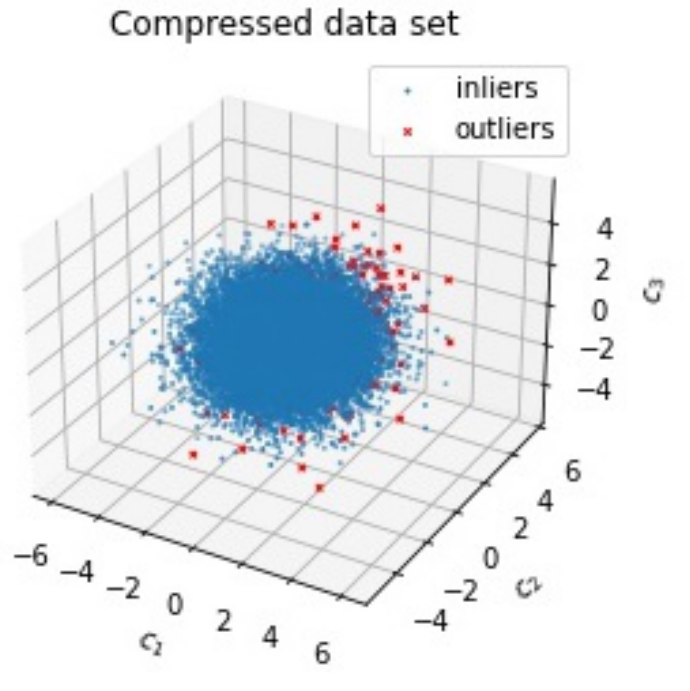
Figure 3. Draw from the mixture DGP